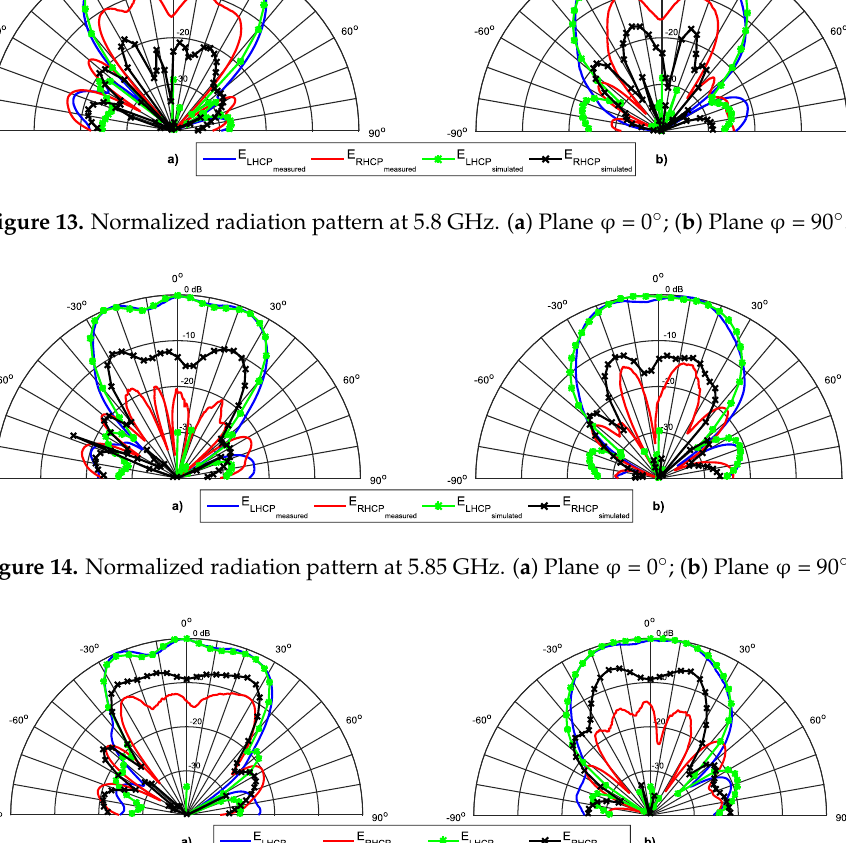
Figure 15. Normalized radiation pattern at 5.9 GHz. ( a ) Plane φ = 0°; ( b ) Plane φ = 90°.